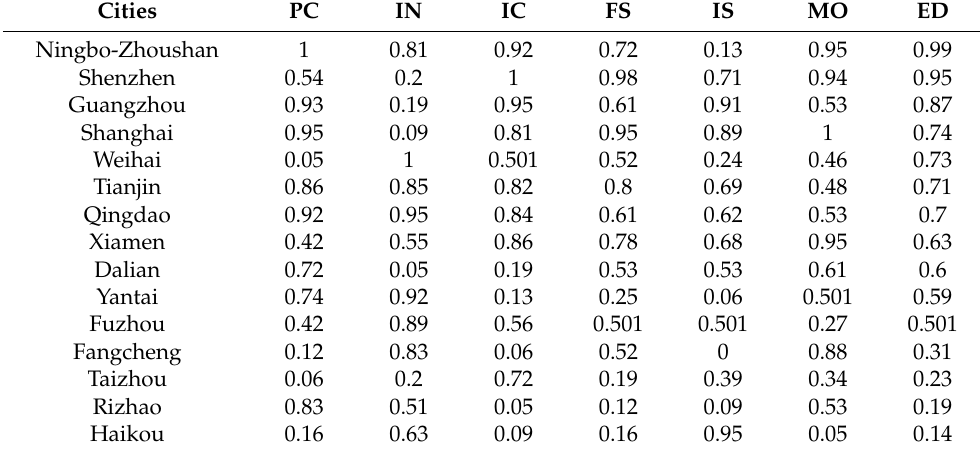
Table 4. Fuzzy-set